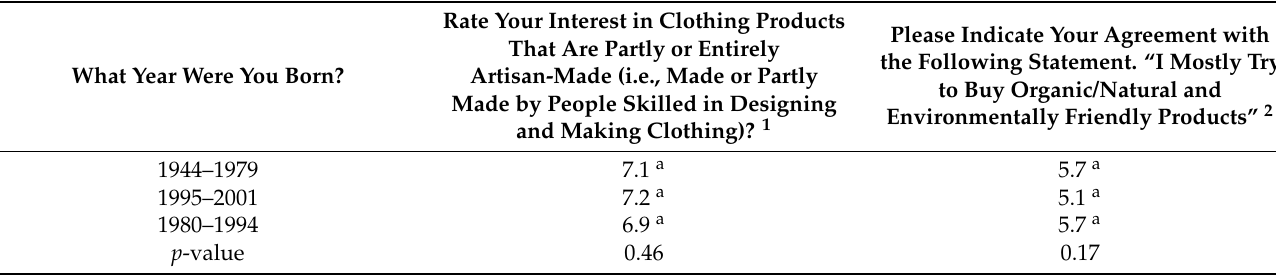
Table 5. LS means for consumers’ interest in artisan products and willingness to purchase environmentally friendly products ( n = 196; α = 0.05).